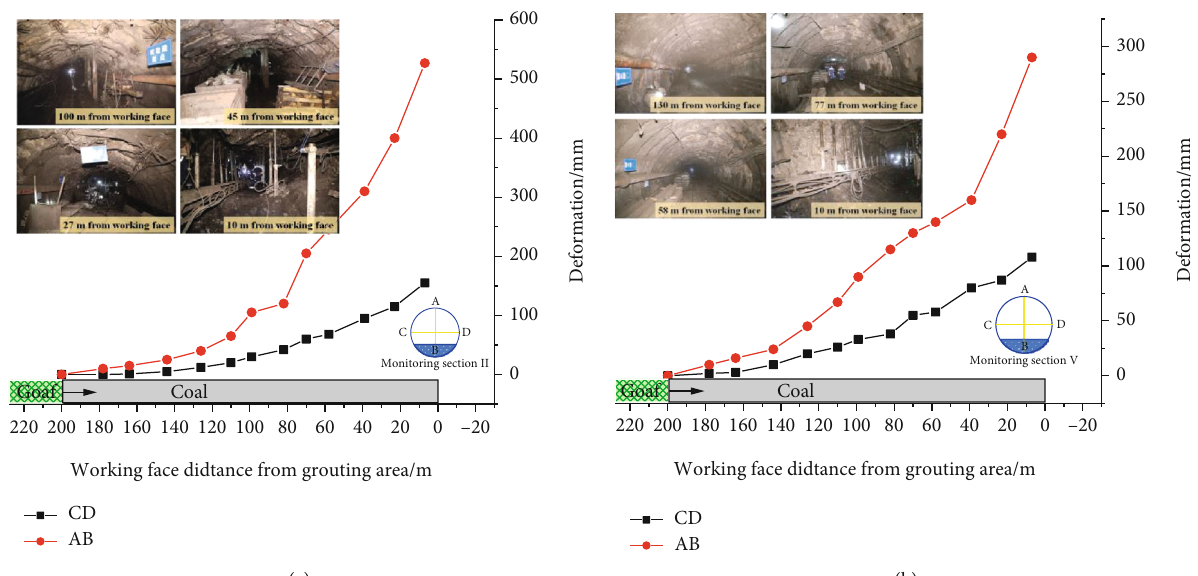
Figure 15: Statistics of the maximum deformation of the test section. (a) Displacement between the roof and fl oor. (b) Displacement of the two sides of the